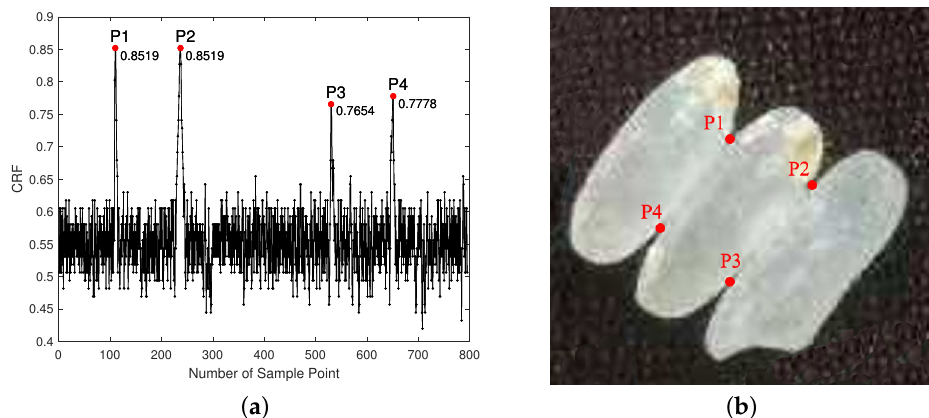
Figure 5. Corner response. Along the rice boundary, the CRF of each pixel is calculated. The response curve of the corner point is obtained, and the corresponding corner point in the image is found according to the local maximum point in the curve. ( a ) Corner response curve. ( b ) Corner points correspond to points on the image.